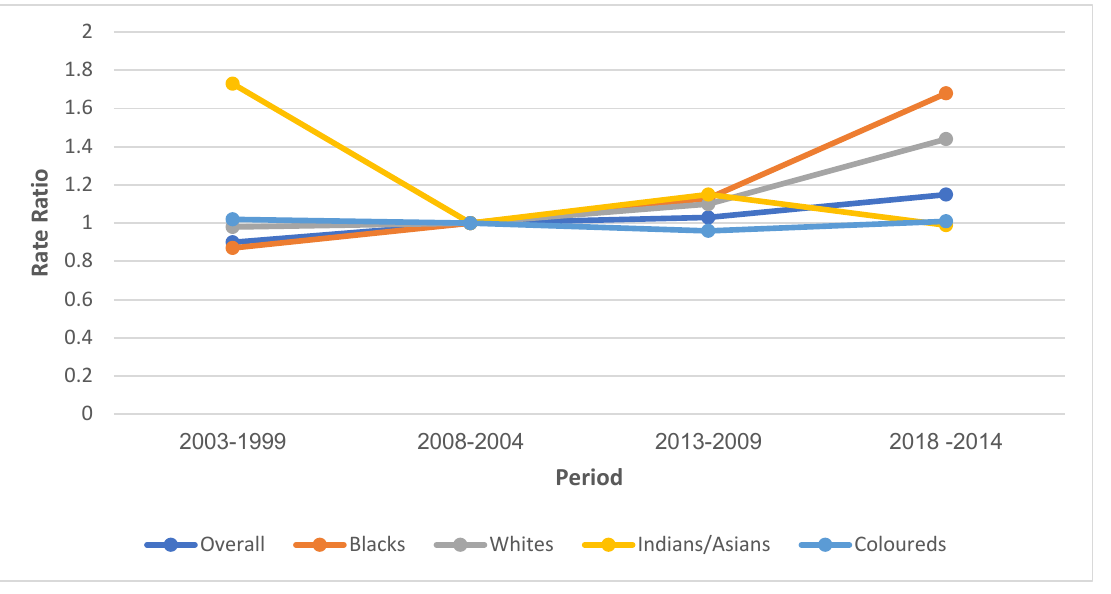
Figure 6. Period Risk ratio of the National and ethnic cervical cancer mortality trends in South Africa (1999 – 2018).